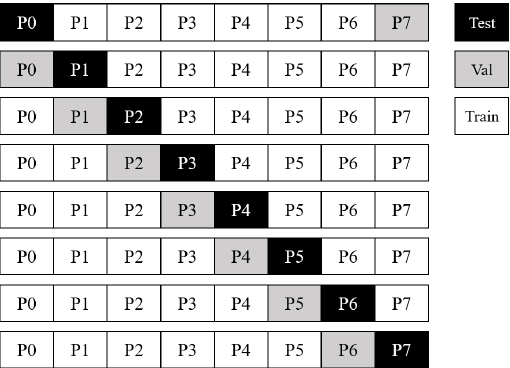
Figure 3. Training, validation, and test sets for the optimal-stopping validation-set group method are colored by use for each participant. For example, the fourth row indicates the model was trained using data from participants [0, 1, 4, 5, 6, 7], validated using participant 2’s data, and evaluated using participant 3 as the hold-out test